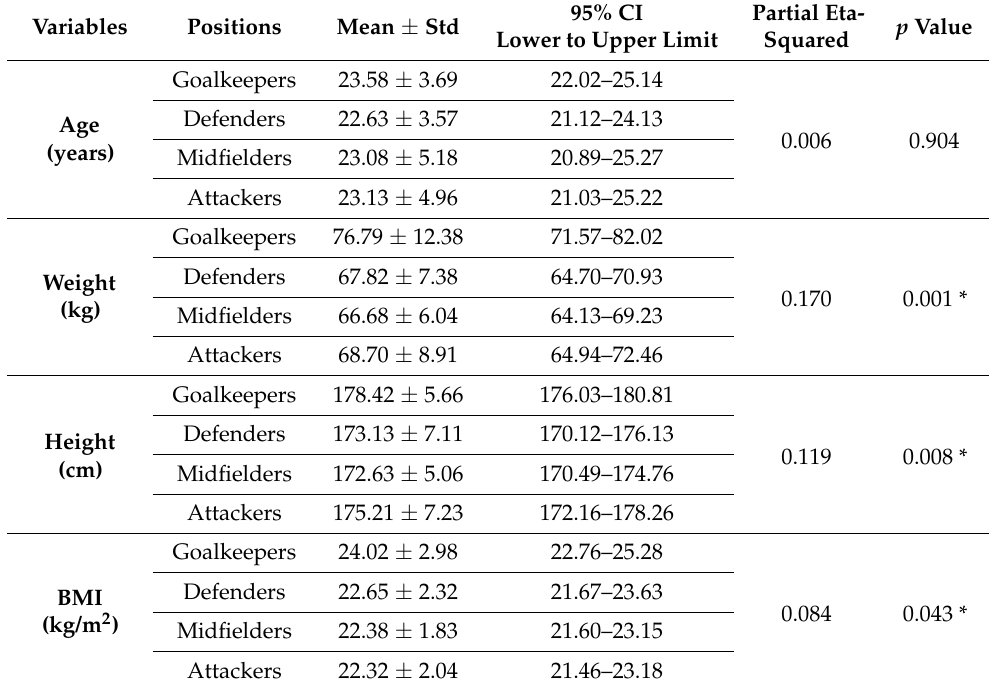
Table 1. Anthropometric characteristics and analysis of variance for the elite soccer players ac-cording to their different playing positions.